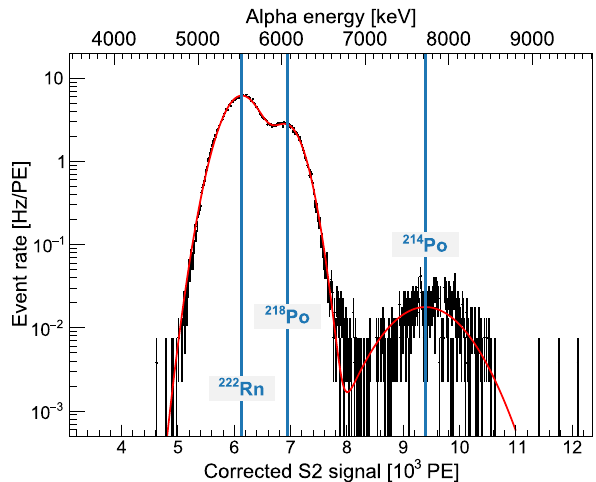
Fig. 14 Corrected charge signal (S2) spectrum of the alpha decays from the 222 Rn-calibration at an electric drift field of